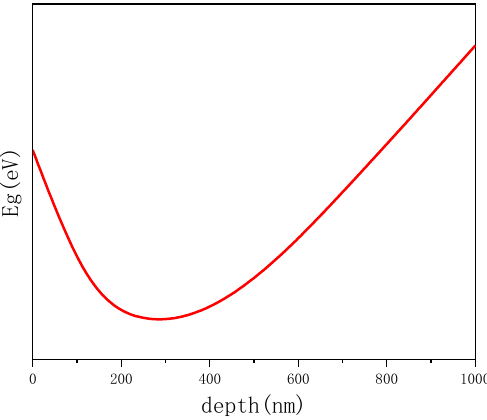
Figure 5. The sketch of Eg depth pro fi le of CIGS absorber.